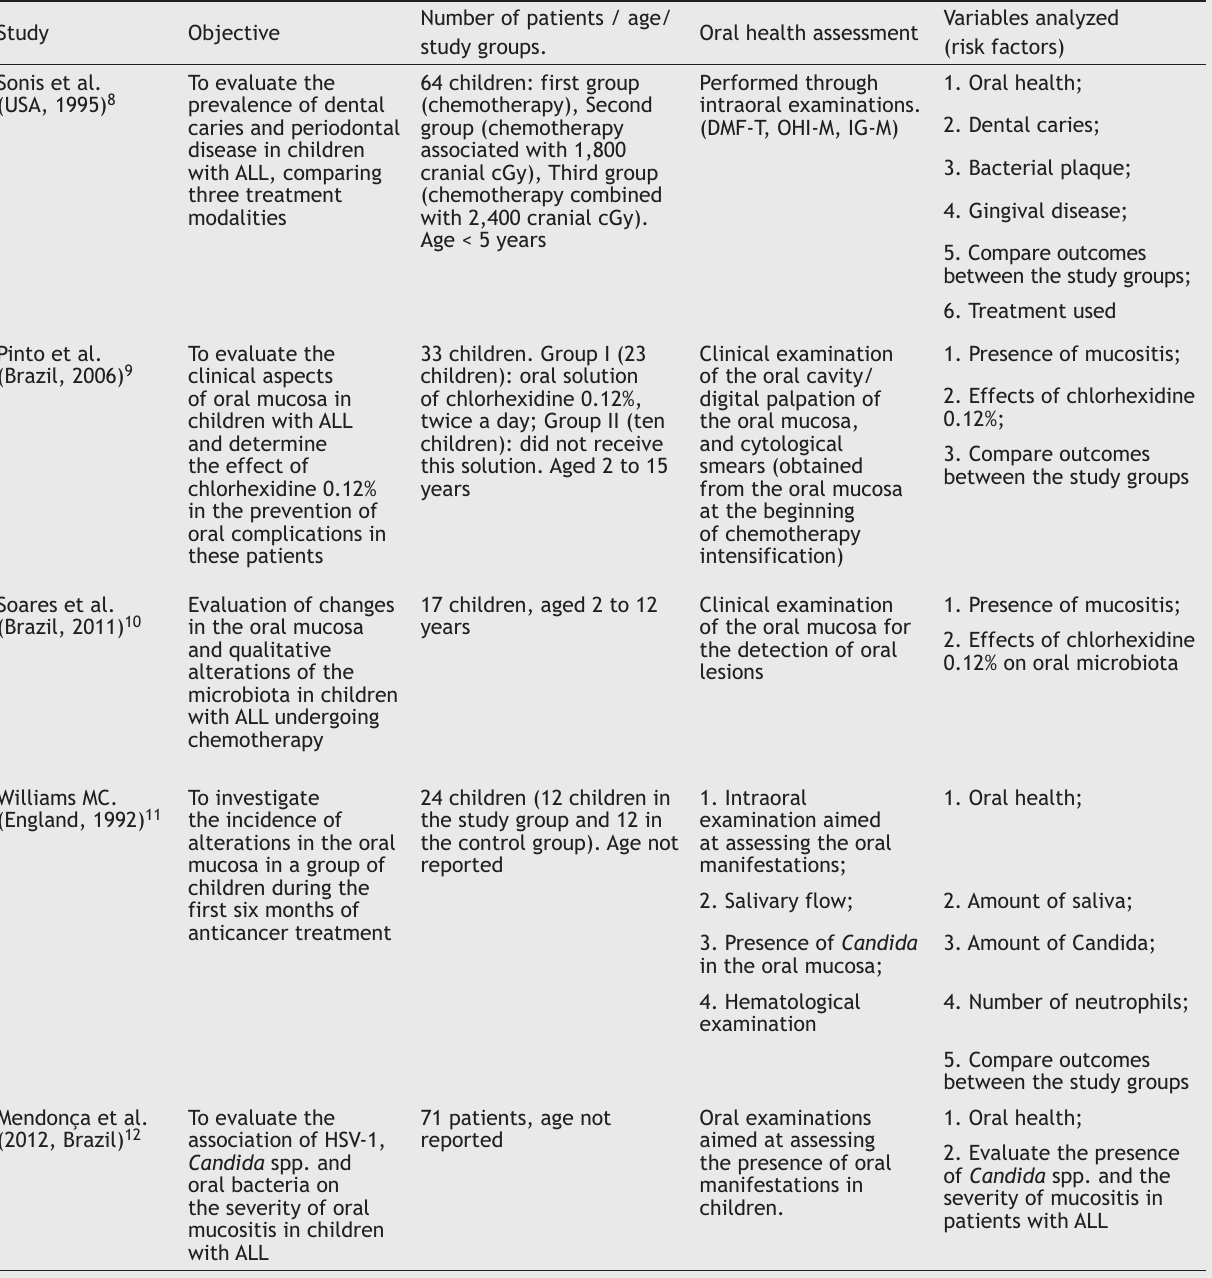
Table 2 Methodology and objectives of the selected studies